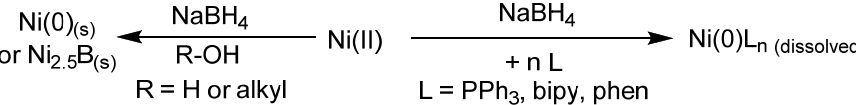
Scheme 7. Reduction of Ni(II) salts produced colloidal Ni(0) or soluble complex of Ni(0) depending on used solvent and/or ligands, respectively [51].